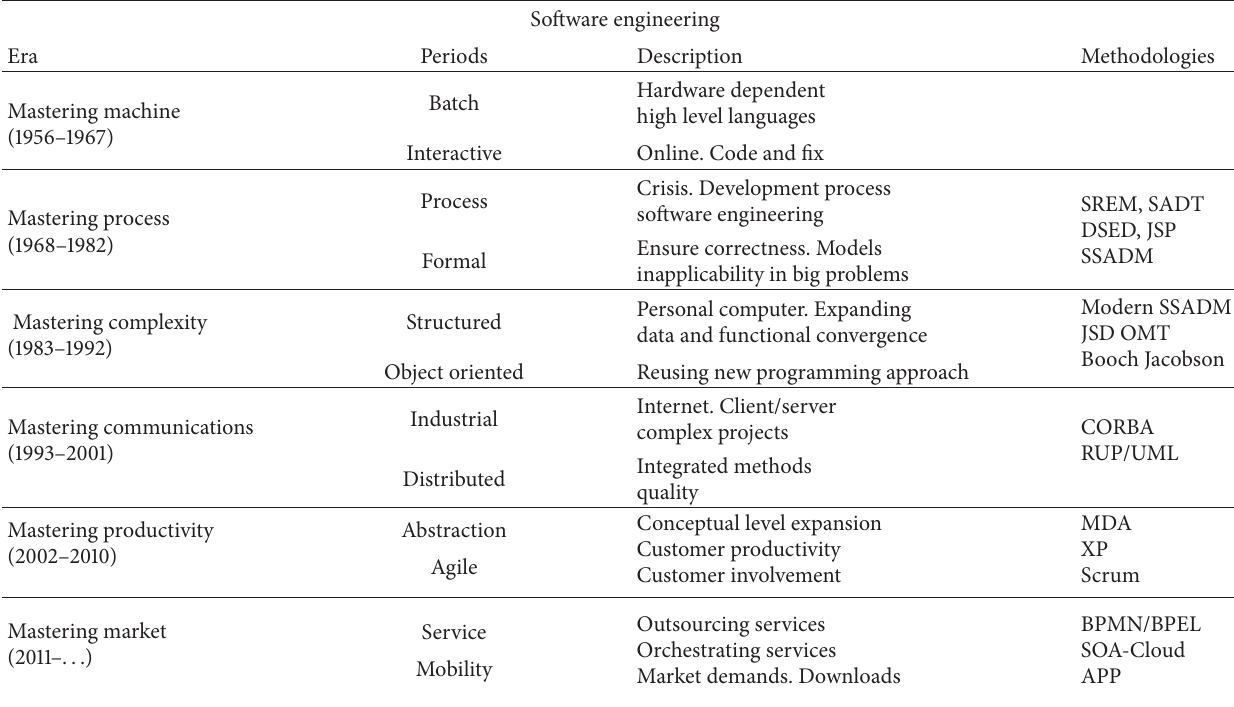
Table 1: Software engineering